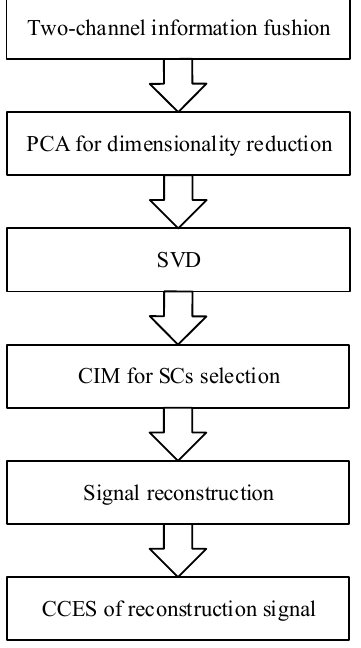
Figure 2. Flowchart of the two-SVD-CIM.